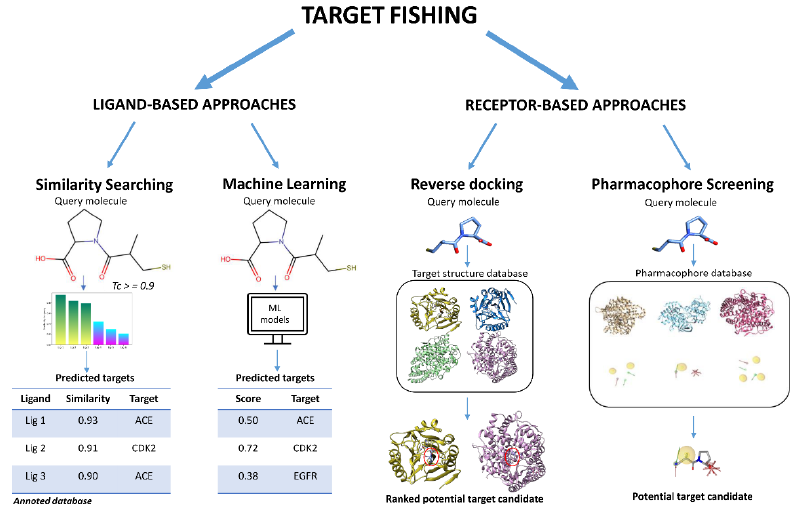
Figure 1. Overview of the main target fishing approaches.